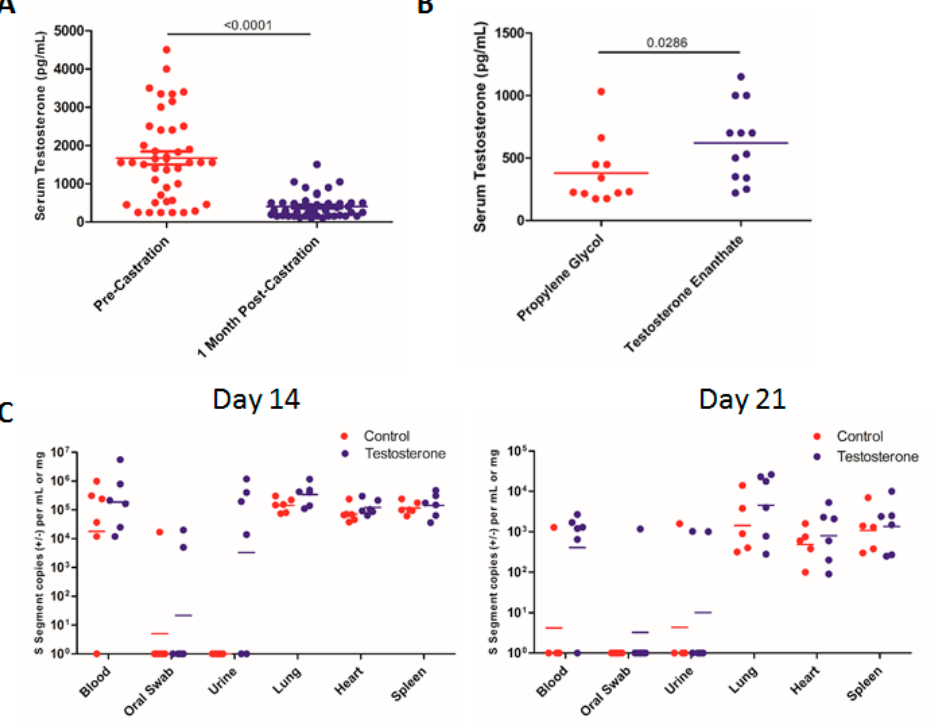
Figure 4. Replication and shedding of SNV in castrated male deer mice given testosterone. ( A ) Serum testosterone levels in deer mice before and 1 month following castration. ( B ) Serum testosterone levels in deer mice implanted with osmotic pumps containing either testosterone enanthate or the control. ( C ) The SNV viral copy number was assessed in the tissues and samples listed at the indicated time points post-infection. The numbers indicate the p value as assessed by a Mann–Whitney test.